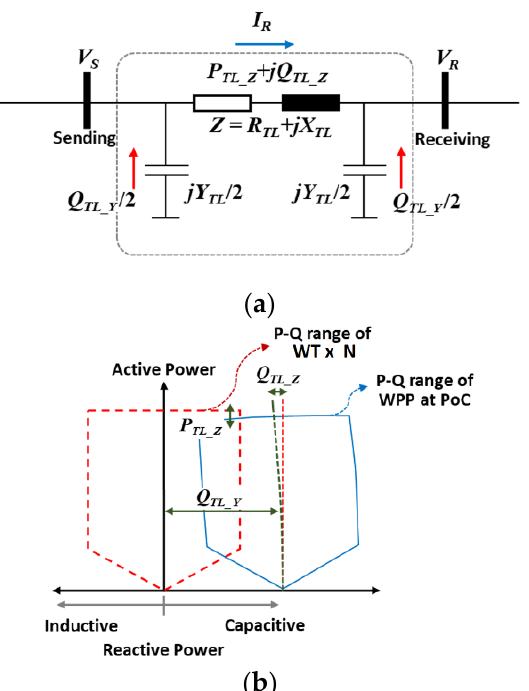
Figure 4. Effects of power transmission cable; ( a ) Equivalent π Circuit for a long transmission line and ( b ) WPP power capability curve at the PoC considering power losses due to the impedance of the transmission line.